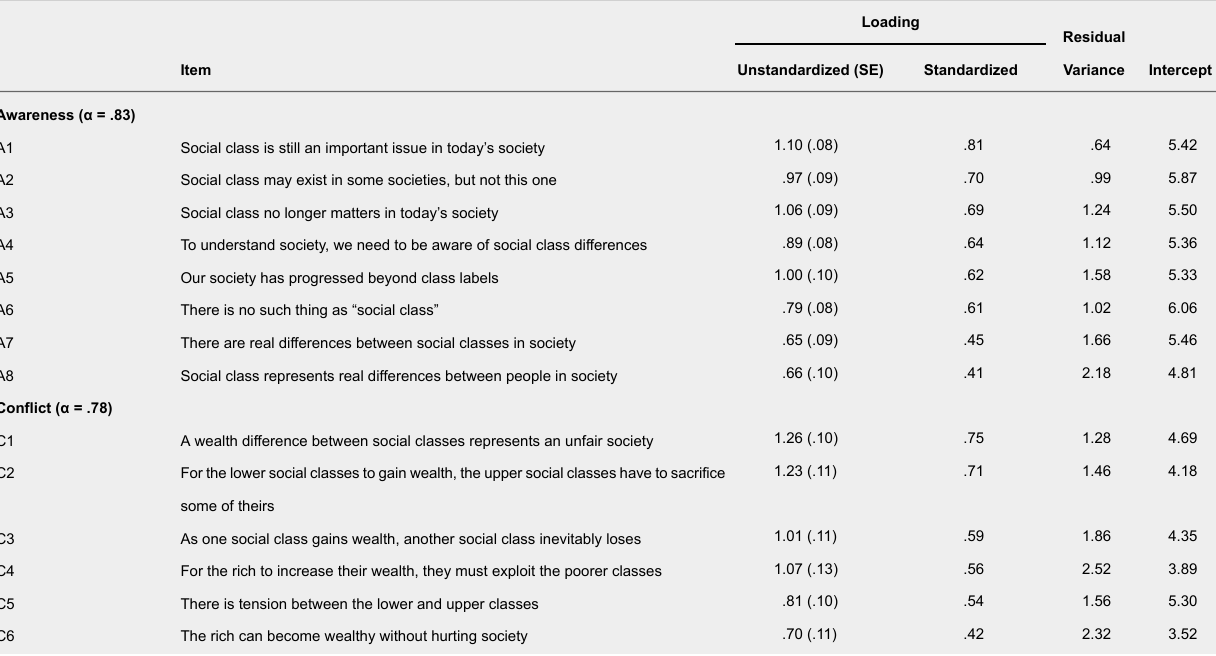
Factor Loadings, Residual Variances, and Intercepts of the Measurement Model by Factor